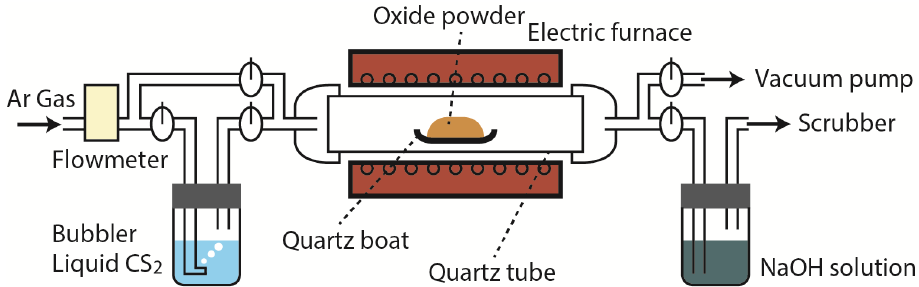
Figure 3. Schematic diagram of the experimental apparatus used for CS 2 sulfurization.